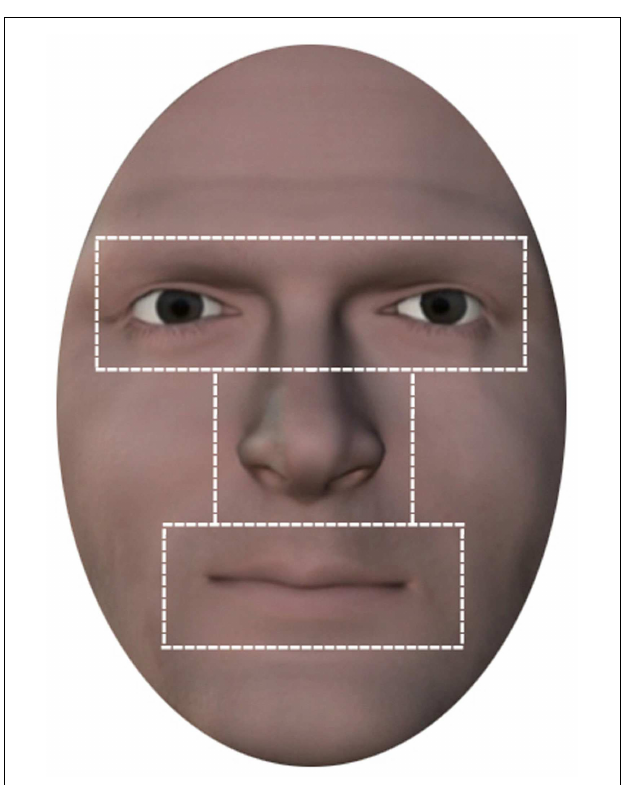
FIGURE 2 |Areas of interest. Illustration of internal region of the face comprising the areas of interest for the facial features eyes, nose,